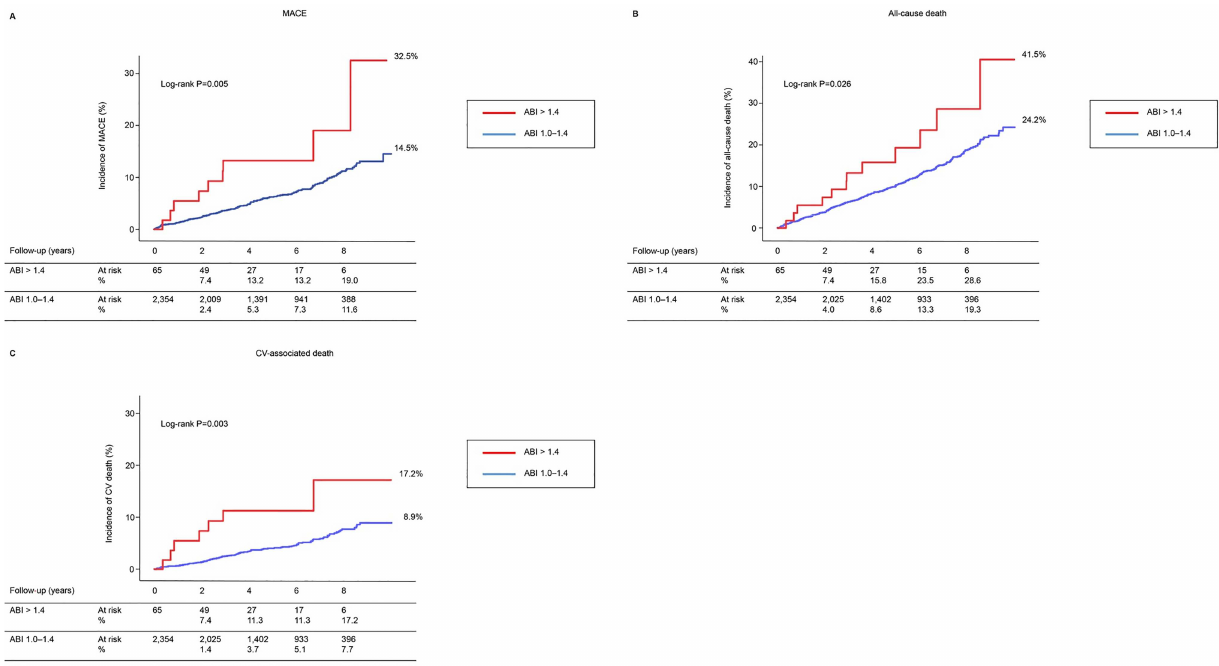
Fig 2. Kaplan-Meier analysisfor (A) major adverse cardiovascular (CV) events (MACE) (CV-associated death, myocardialinfarction, and stroke), (B) all-causedeath, (C) CV-associated death, accordingto the ankle brachialindex (ABI)